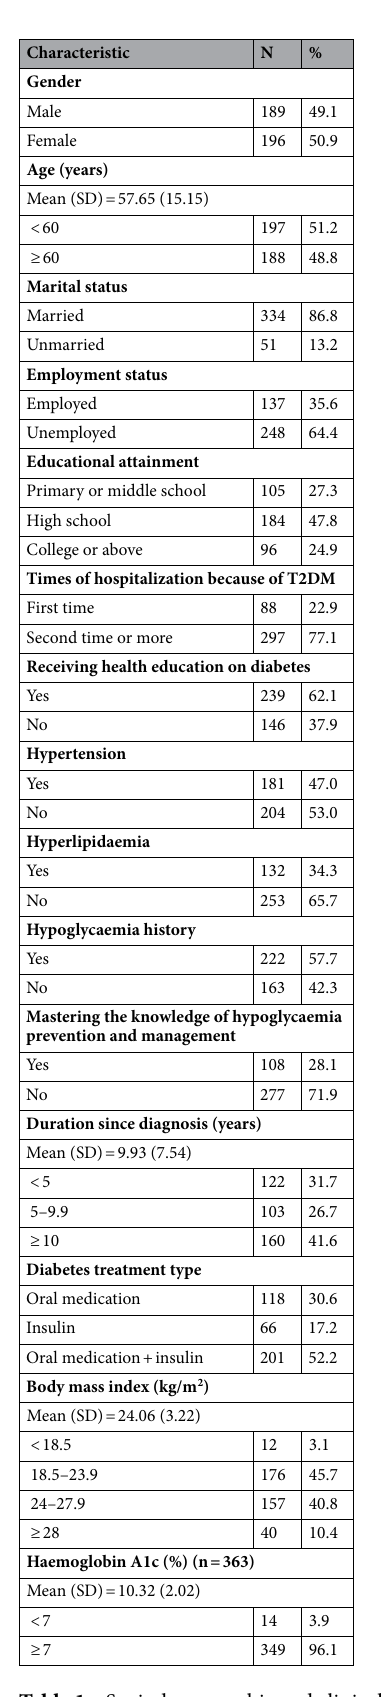
Table 1. Sociodemographic and clinical characteristics of type 2 diabetic patients ( n = 385). SD, standard deviation; T2DM, type 2 diabetes